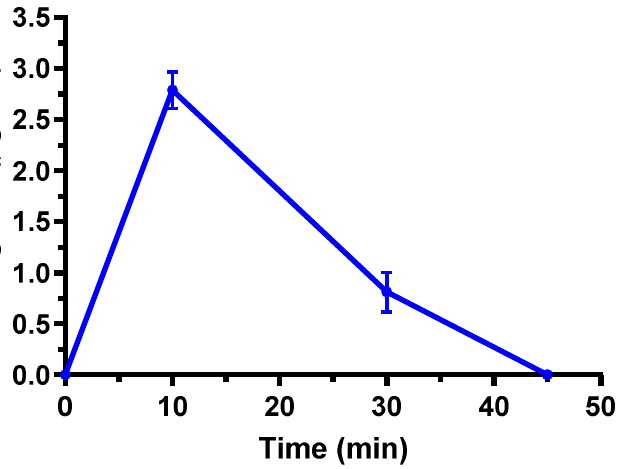
Figure 2. Eugenol concentrations (μg/mL) detected in the CSF of rats after intravenous administra- tion of a 5 mg (20 mg/kg) dose. Data are expressed as the mean ± SE of four independent experi-